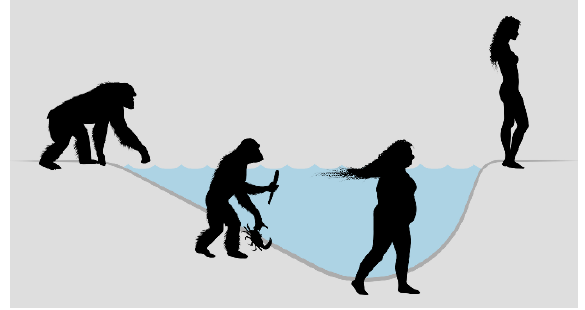
Figure 2. Four possible stages of human peripatric speciation. Chimpanzee-like ape, semiaquatic ape, semiaquatic Homo sapiens , terrestrial Homo sapiens . Intermediate hominins, bipedal but with relatively small brains, are not shown. Illustration by Alex